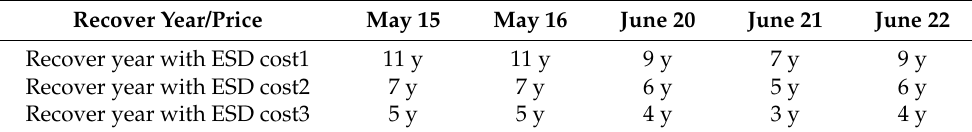
Figure 16. ESD investment recovery period by using the comprehensive optimization algorithm. Table 6. Recover year of ESD.